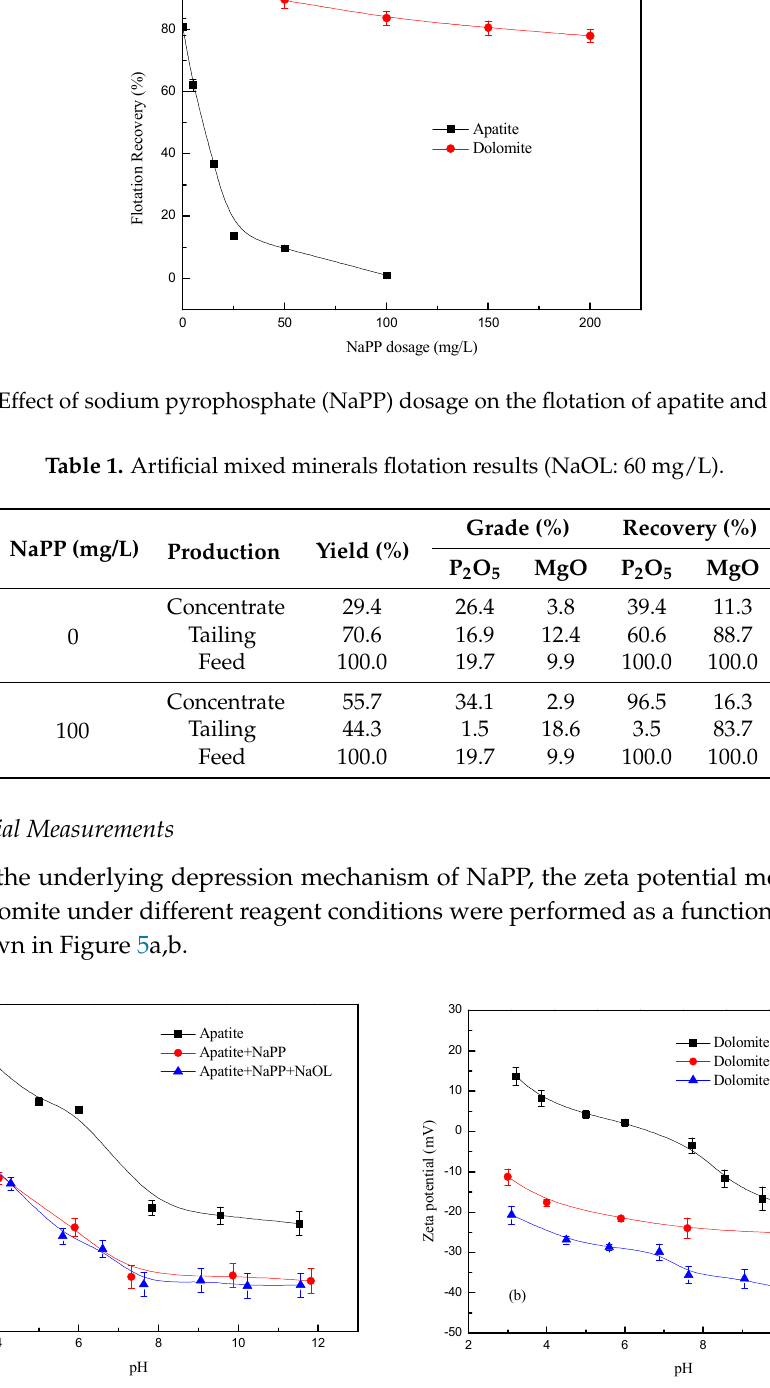
Figure 5. Effect of different reagents on the zeta potential of ( a ) apatite and ( b ) dolomite.